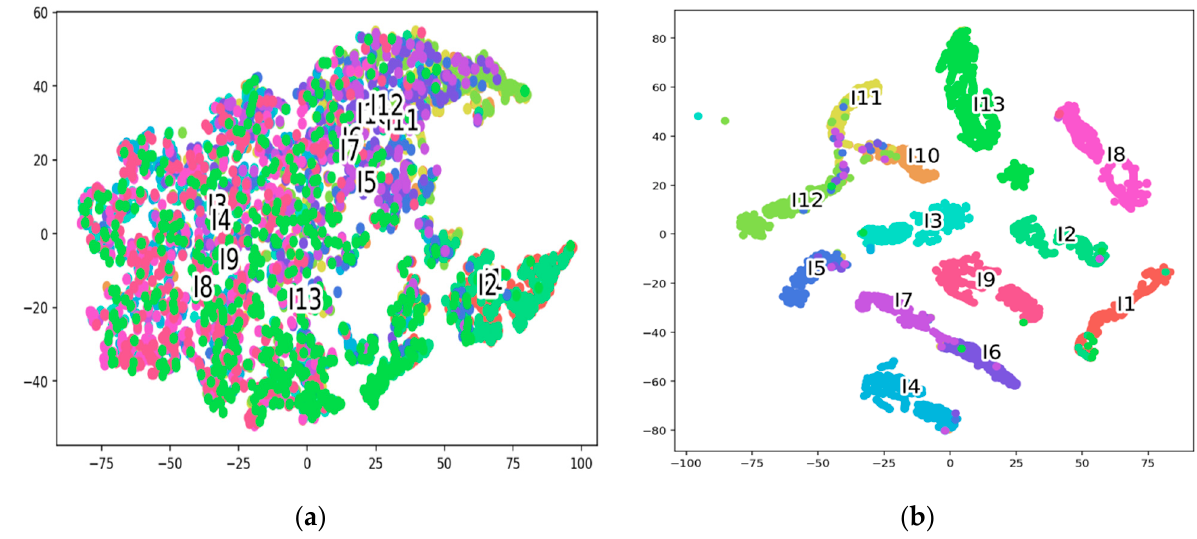
Figure 6. T-SNE visualization of test data before ( a ) and after ( b ) the proposed model learning representations.